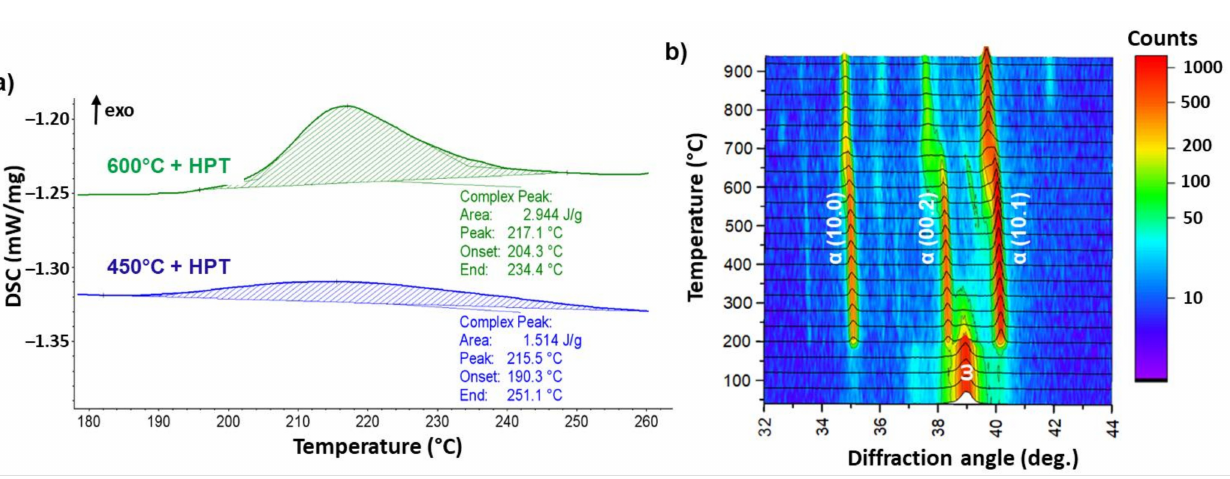
Figure 10. Enlarged part of the DSC heating curves of the deformed Ti–3wt.% Nb alloy pre-annealed at 450 and 600 ◦ C ( a ). The XRD in situ heating map of the deformed Ti–3wt.% Nb alloy, pre-annealed at 600 ◦ C ( b ). At the given 2 θ angle interval, the ω -phase is presented by (11.0 + 10.1) a doublet of